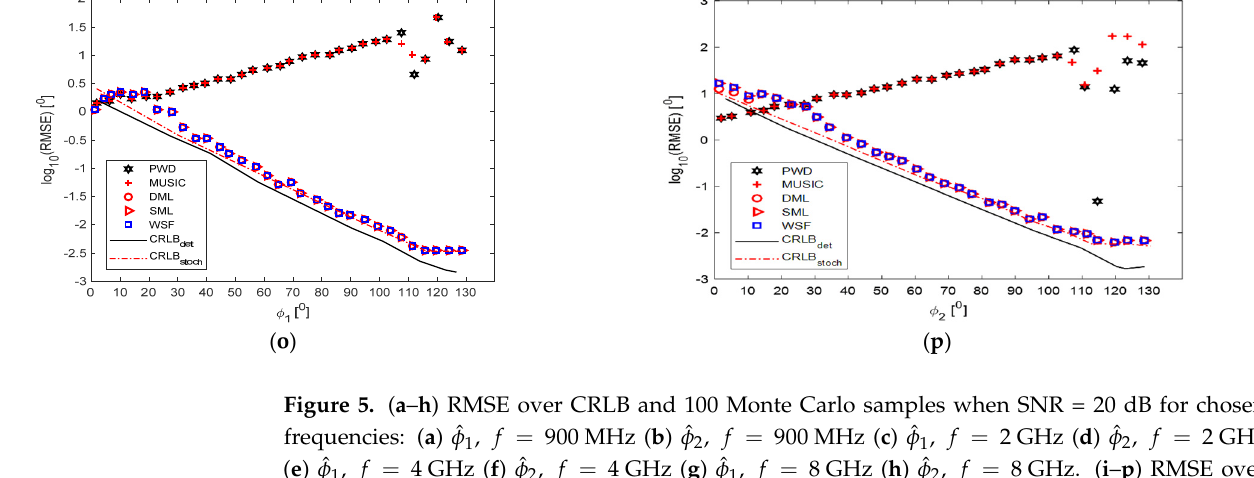
Figure 5. ( a )–( h ) RMSE over CRLB and 100 Monte Carlo samples when SNR = 20 dB for chosen frequencies: ( a ) 𝜙(cid:3552) (cid:2869) ,𝑓 = 900 MHz ( b ) 𝜙(cid:3552) (cid:2870) , 𝑓 = 900 MHz ( c ) 𝜙(cid:3552) (cid:2869) , 𝑓 = 2 GHz ( d ) 𝜙(cid:3552) (cid:2870) ,𝑓 = 2 GHz ( e ) 𝜙(cid:3552) (cid:2869) , 𝑓 = 4 GHz ( f ) 𝜙(cid:3552) (cid:2870) ,𝑓 = 4 GHz ( g ) 𝜙(cid:3552) (cid:2869) ,𝑓 = 8 GHz ( h ) 𝜙(cid:3552) (cid:2870) , 𝑓 = 8 GHz . ( i )–( p ) RMSE over CRLB and 100 Monte Carlo samples when SNR = 20 dB for chosen frequencies: ( i ) 𝜙(cid:3552) (cid:2869) , 𝑓 = 16 GHz ( j ) 𝜙(cid:3552) (cid:2870) , 𝑓 = 16 GHz ( k ) 𝜙(cid:3552) (cid:2869) ,𝑓 = 32 GHz ( l ) 𝜙(cid:3552) (cid:2870) ,𝑓 = 32 GHz ( m ) 𝜙(cid:3552) (cid:2869) ,𝑓 = 40 GHz ( n ) 𝜙(cid:3552) (cid:2870) , 𝑓 = 40 GHz ( o ) 𝜙(cid:3552) (cid:2869) , 𝑓 =